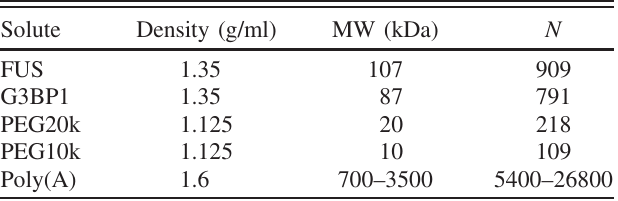
TABLE IV. Physical parameters used in